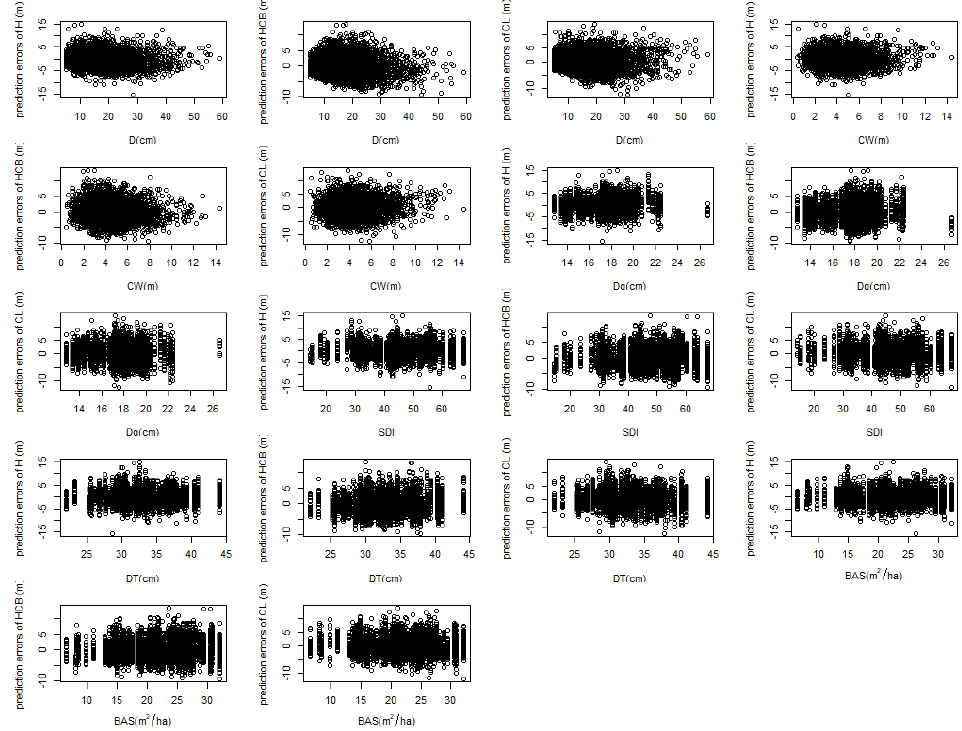
Figure 10. Prediction errors against predictors of Equation (20) ( D : diameter at breast height (cm); CW : crown width (m); Dg : mean quadratic D (cm); SDI : stand density index; DT : stand dominant D (cm); BAS : stand basal area (m 2 ·ha − 1 )).